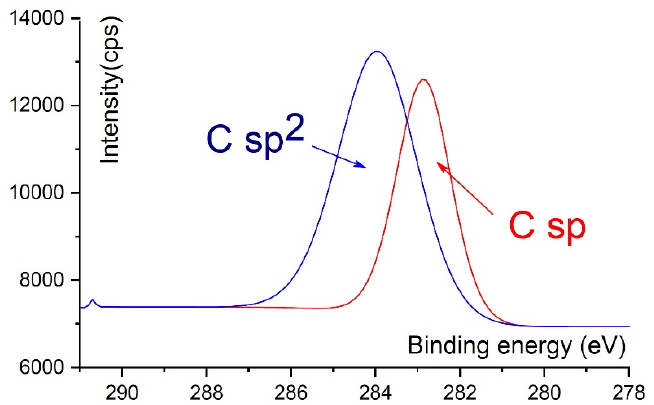
Figure 10. An example of the binding energy ratio for carbyne (sp) and graphene-like (sp2) hybridized bonds, obtained using X-ray photoelectron spectroscopy (XPS).